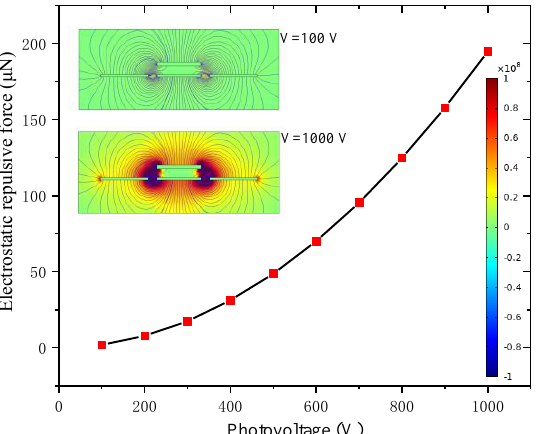
Figure 4. Electrostatic repulsive force versus the applied photovoltage ( d 1 = d 2 = 4 μm, W m = 20 μm, W f = 22 μm and h m = 2 μm).